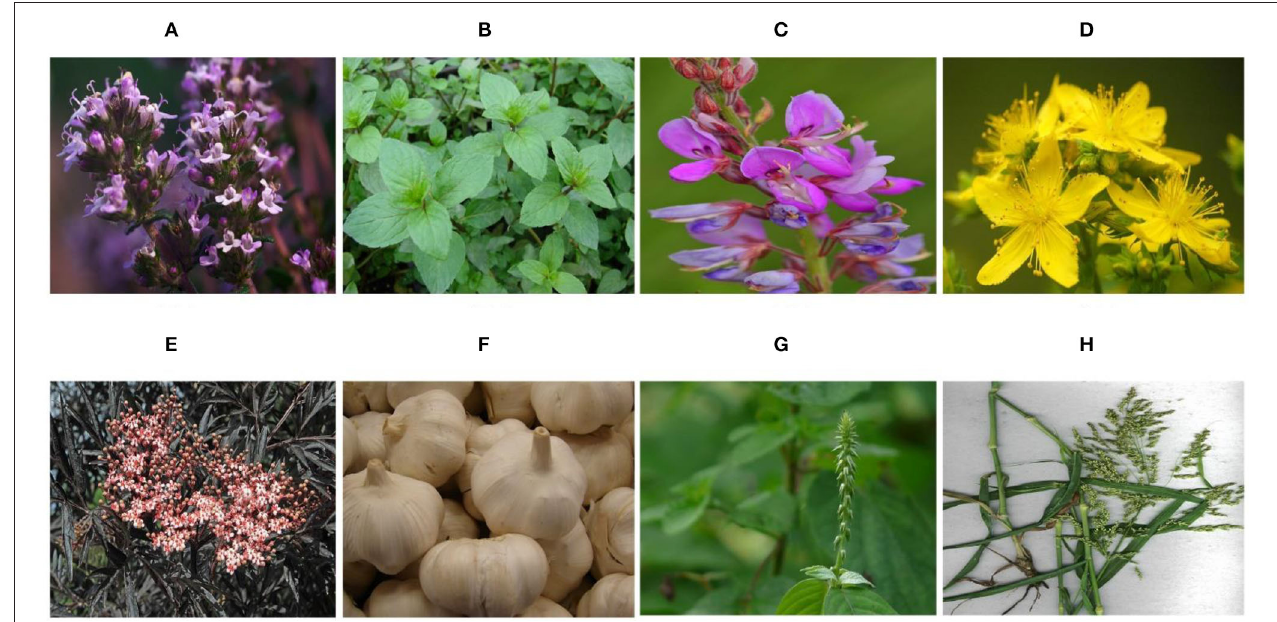
FIGURE 1 | Plants in therapeutics to control infectious bronchitis (IB). (A) Thymus vulgaris (45). (B) Mentha piperita (46). (C) Desmodium canadense (47). (D) Hypericum perforatum (48). (E) Sambucus nigra (49). (F) Alium sativum (50). (G) Achyranthes aspera (51), and (H) Panicum antidotale